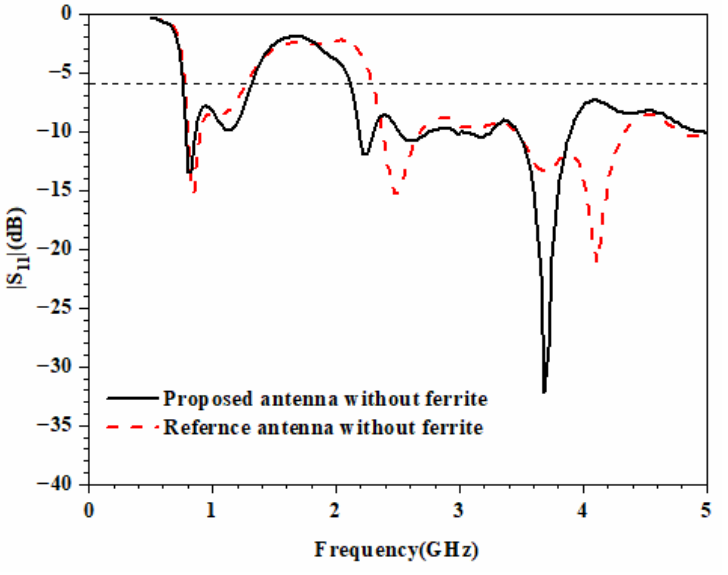
Figure 2. Simulated |S 11 | of the proposed antenna and the reference antenna without ferrite slab.